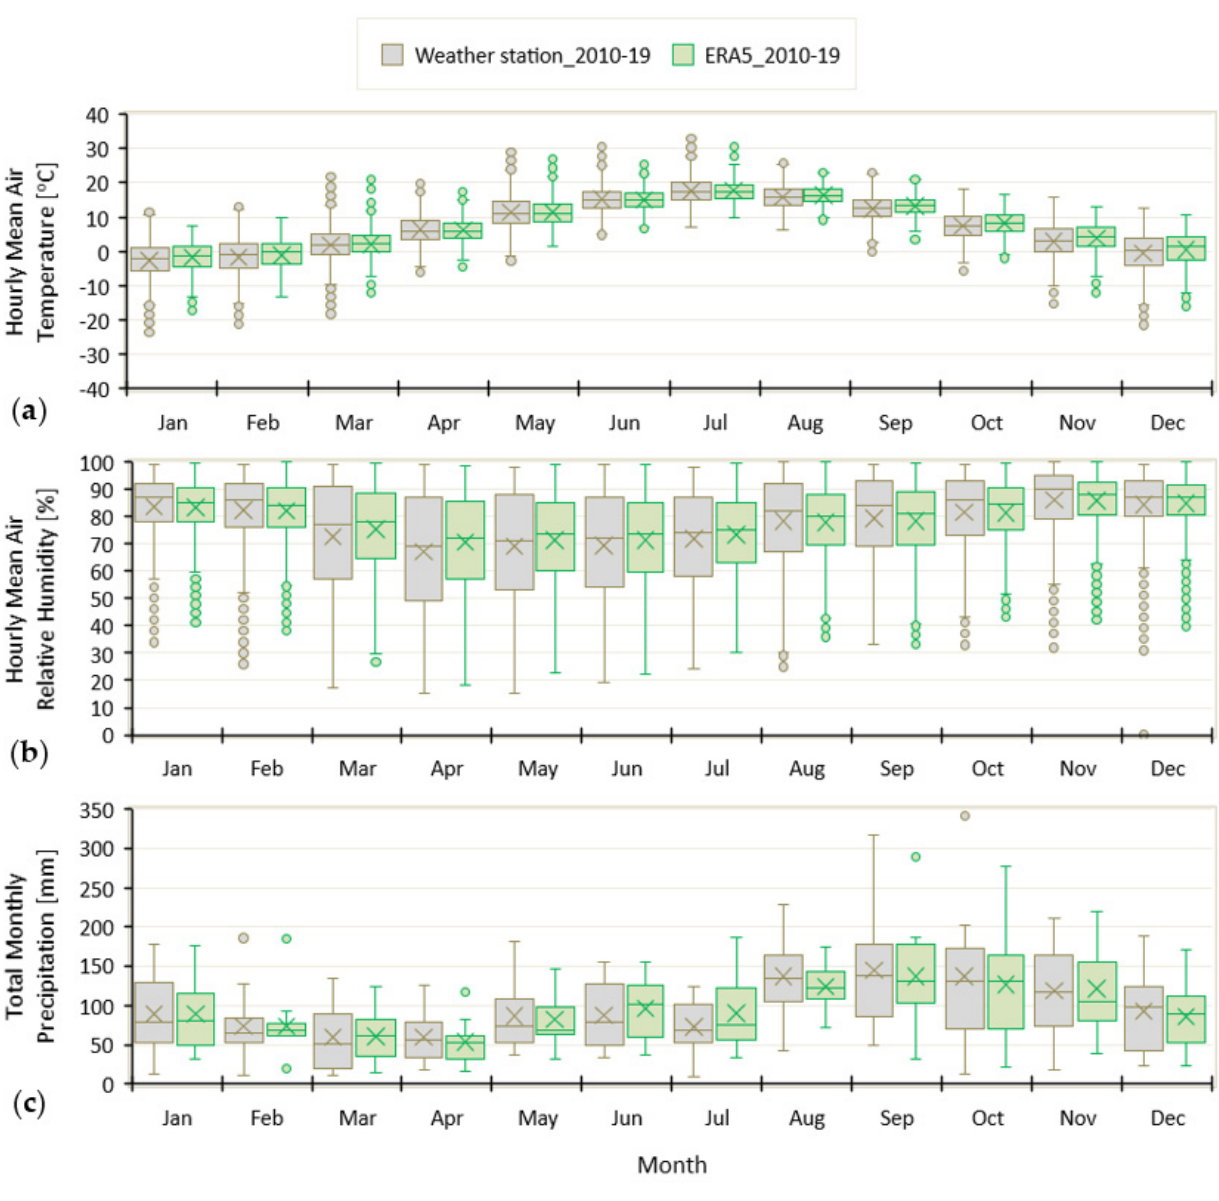
Figure 4. Comparison between ( a ) air temperature, ( b ) air relative humidity and ( c ) precipitation data derived from the Melsom weather station that is located 5 km from the study site, and from the ERA5 reanalysis. In the boxplots the box shows 50% of the data, with median represented as a horizontal bar and the average value highlighted with the ‘x’ symbol. The whisker extends to two standard deviations of the data and the circles represent the outliers.